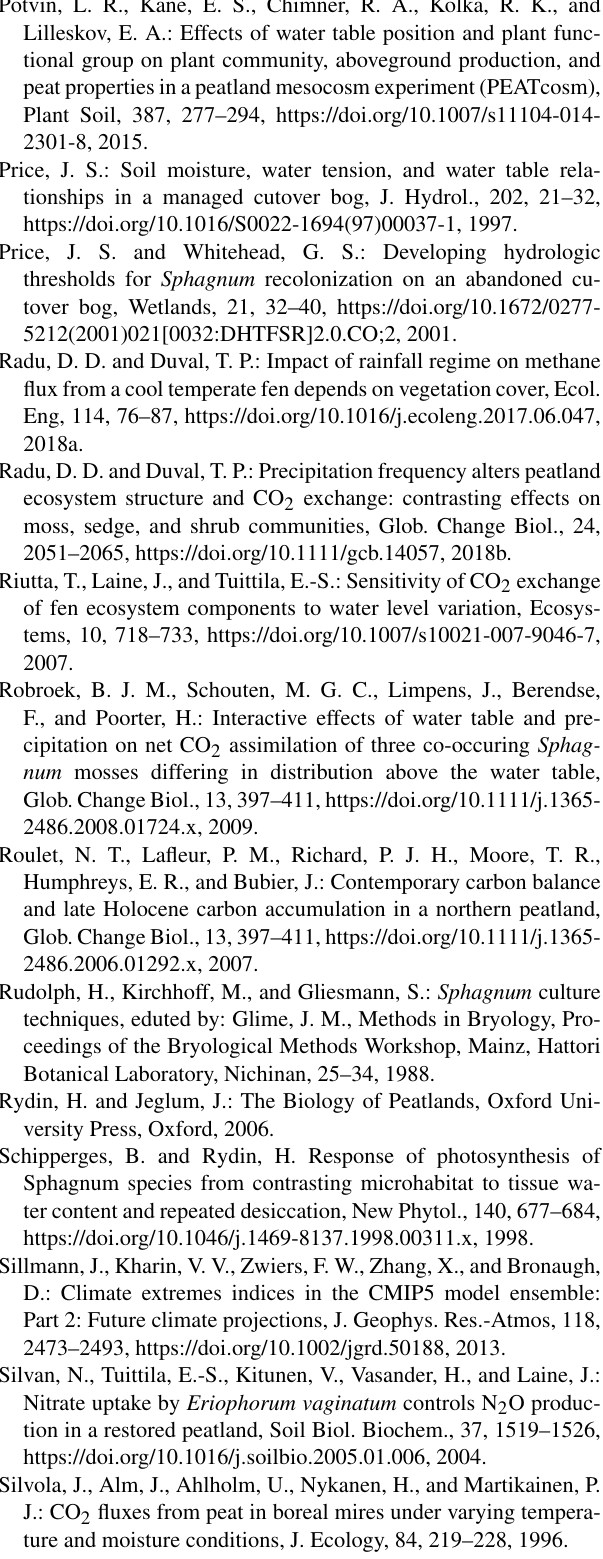
ter table drawdown, J. Geophys. Res.-Biogeo., 111,